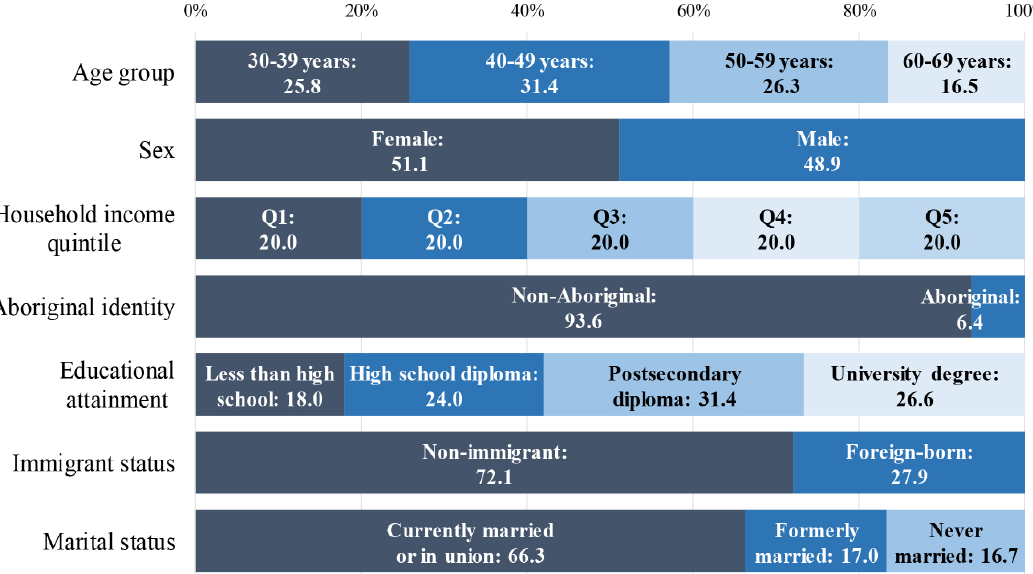
Source: 2006 Canadian Population Census linked to the 2006 / 07–2008 / 09 Discharge Abstract Database (N = 2,413,560). Data exclude residents of Quebec and the territories